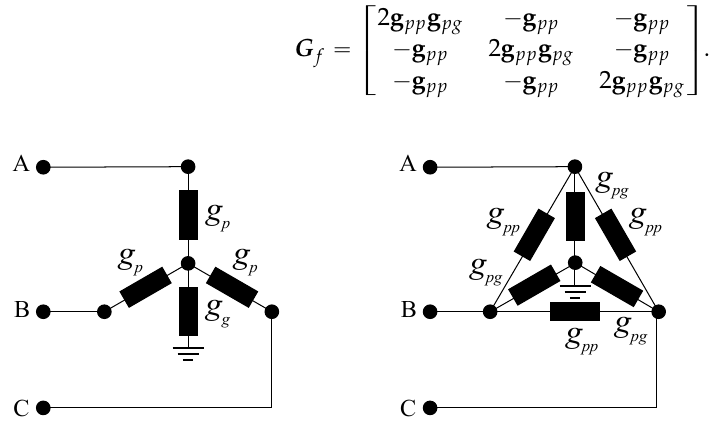
Figure 3. Star-mesh transformation for a three-phase to ground